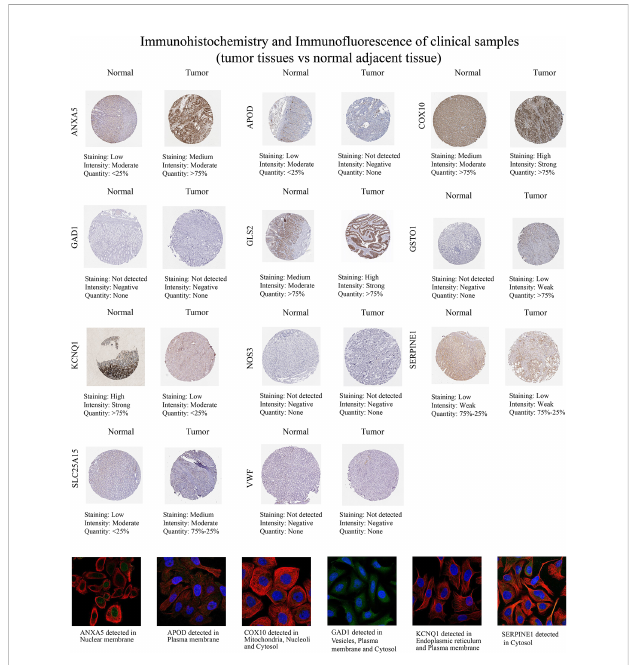
FIGURE 12 Immunohistochemistry and immuno fl uorescence of clinical samples (tumor tissues vs normal nearby